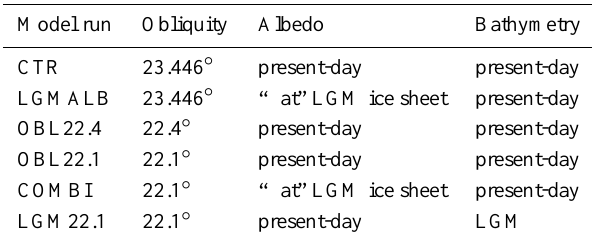
Table 2. Acronym, obliquity, albedo and bathymetry for different model runs. For all runs eccentricity, precession, sea level, land topography and atmospheric CO 2 concentration were kept at pre- industrial